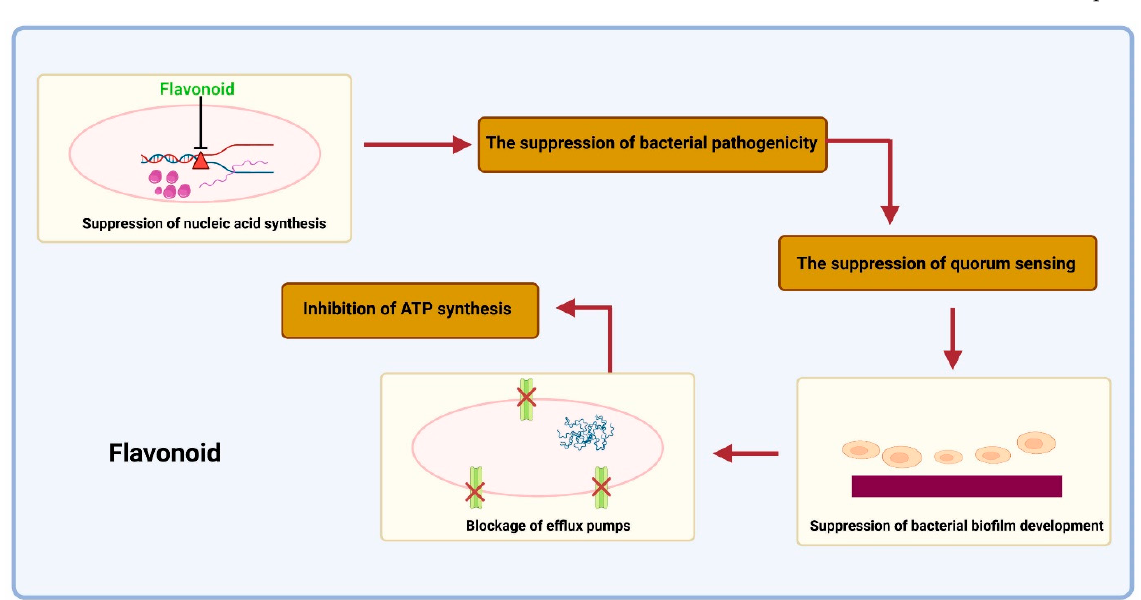
Figure 4. The detrimental suppression of bacterial pathogenicities by flavonoids. Toxins, quorum sensing, dihydrofolate reductase (DHFR), helicases, and gyrase/topoisomerase inhibitors suppress nucleic acid synthesis. The capacity to produce biofilms then inhibits the synthesis of the cell envelope. Subsequently, it involves blocking the enzyme fatty acid synthase (FAS—5) and peptidoglycan production (suppression of Ala-Ala dipeptide synthesis, inhibition of peptidoglycan cross-linking). Additionally, flavonoids can block efflux pumps, which may result in the reversal of antimicrobial resistance. Then, the bacterial respiratory chain’s ATP synthase and NADH-cytochrome c reductase activities are